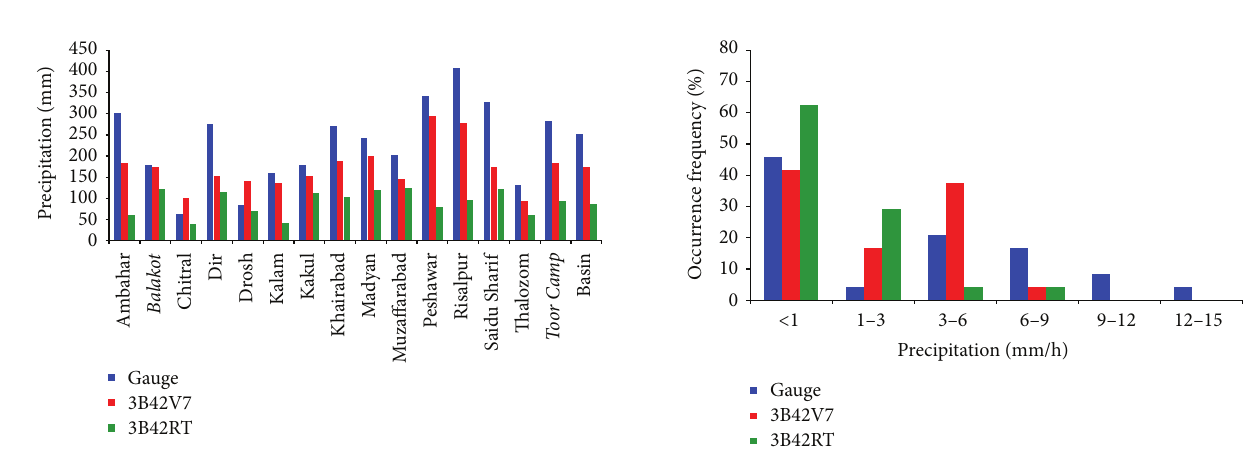
Figure 5: Occurrence frequencies of gauge, 3B42V7, and 3B42RT for areal-averaged